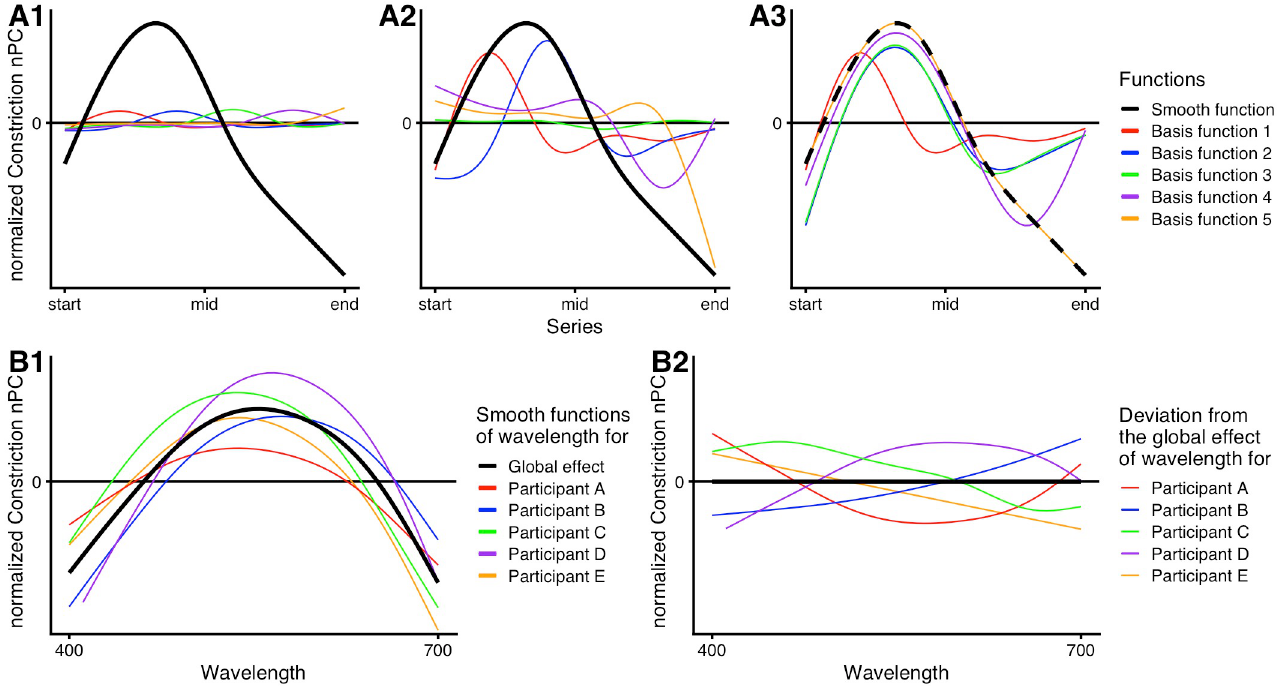
Fig 3. Concepts of additive (mixed-effect) models. (A) Construction of a smooth through basis expansion . Every smooth is constructed from a number of basis functions, usually spread evenly across the value range of a predictor. In the shown case, five cubic regression splines were used as basis functions to demonstrate the concept. The thick black line represents the final smooth function, describing the relationship between the predictor and the outcome variable. Colored traces show the basis functions. (A1) Unscaled basis functions—their type and maximum number are part of the input for model generation. (A2) Scaled basis functions—for each basis function, a respective weight is estimated by which the function is scaled. (A3) Summation of basis functions, starting with the first and then, successively, adding the others; the generated smooth can then be used for prediction. The smooth is shown as dashed curve to show that, with the addition of the last basis function (orange line), the resulting curve is equal to the smooth function. (B) Concept of global effects with random smooths . (B1) The thick black line represents the global effect, describing the average relationship between the predictor and outcome variable. Colored traces show the individual’s effect of the same predictor, demonstrating interindividual differences. The model takes these differences into account through the so-called random smooths (i.e. “random” in that their contribution depends on the subject). (B2) Random smooths are smooths describing the deviations from the global effect. The colored traces show the deviations present in panel B1. Because the global smooth and the random smooths are estimated together, the deviations disappear on average, i.e., not all deviations will tend in the same direction, but are spread around the global